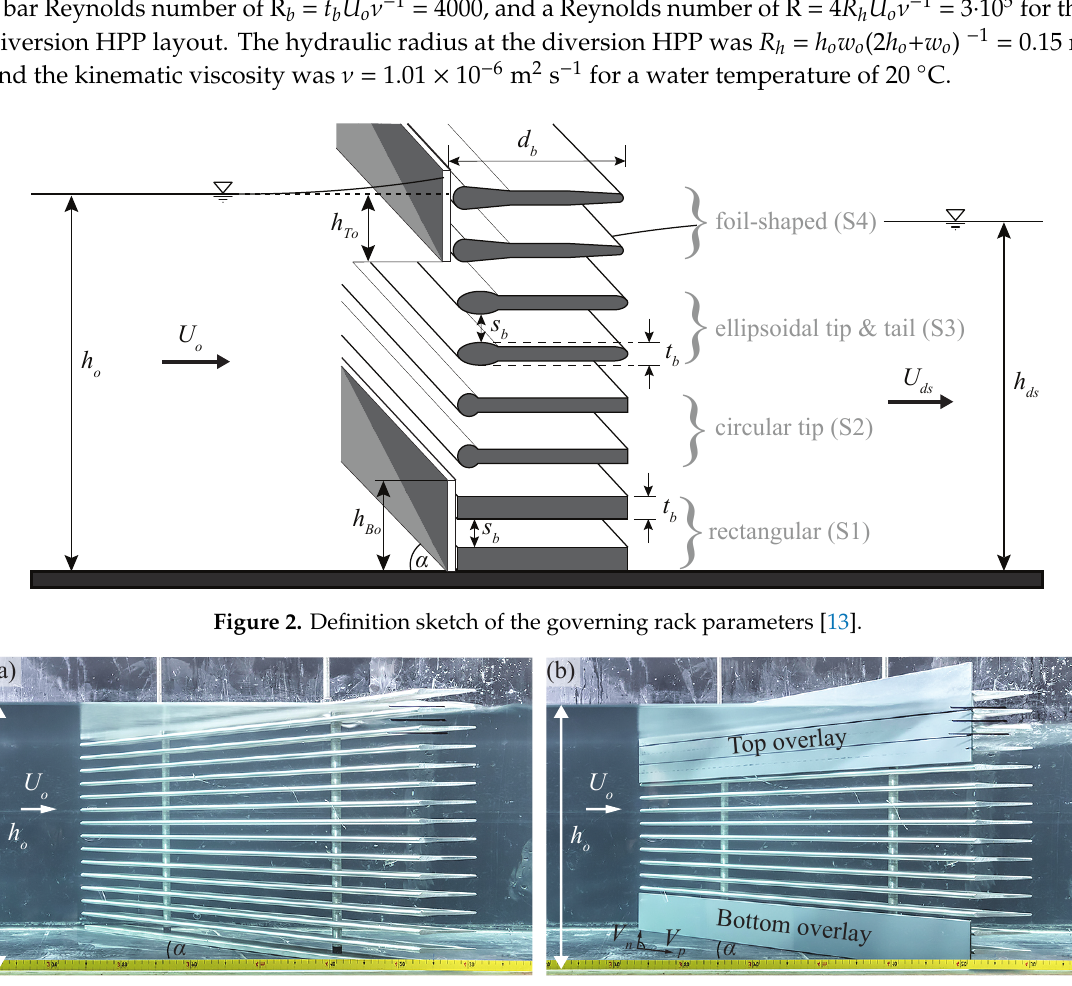
Figure 3. Side view of the rack with foil-shaped bars (S4), s b = 20 mm, α = 45 ◦ ( a ) without overlays ( H Ov = 0) and ( b ) with H Bo = H To =